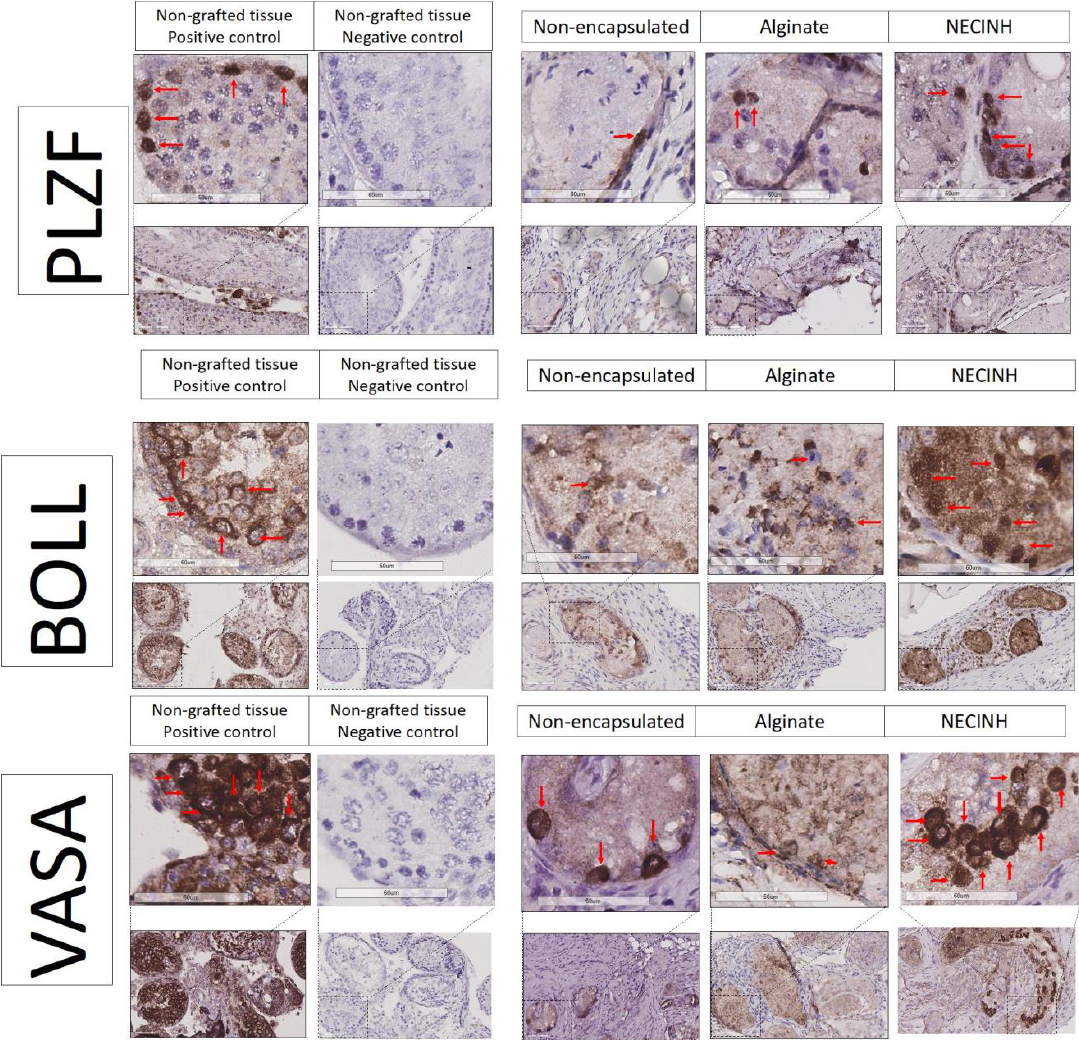
Figure 8. Impact of NECINH-NPs on germ cells survival in mice testicular tissue auto-transplanted for 21 days. Images show 40 X magnification of IHC for PLZF, BOLL, and VASA. Positive cells are highlighted by red arrows.